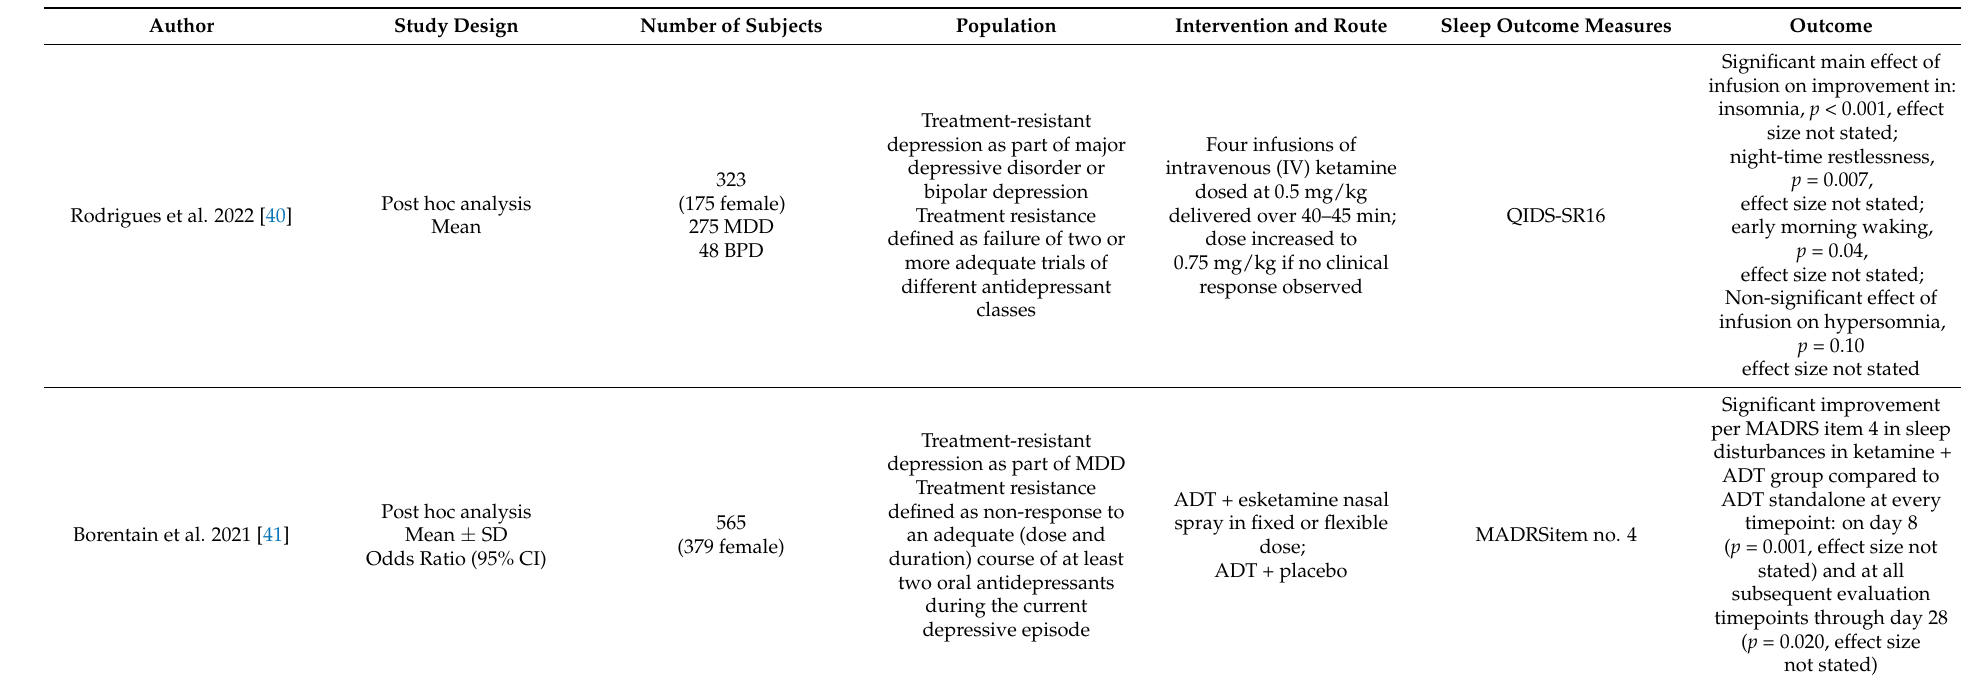
Table 1. Studies on ketamine’s impact on sleep